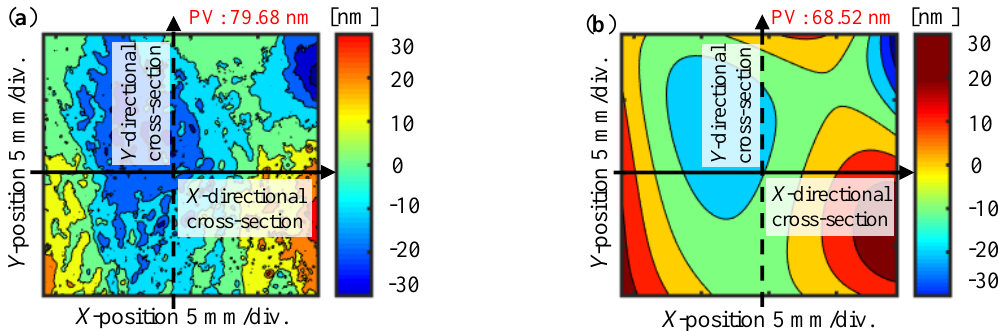
Figure 9. Measured and fitted results of the Y ′ -directional pitch deviation. ( a ) Measured Y ′ -directional pitch deviation ( b ) Y ′ -directional pitch deviation fitted by a polynomial.